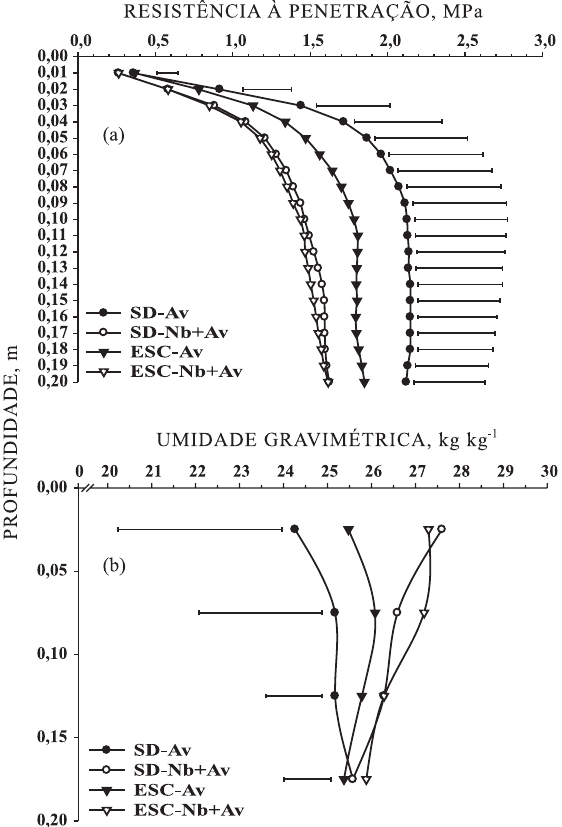
Figura 2. Resistência à penetração (a) e umidade gravimétrica (b) de um Latossolo Vermelho distroférrico sob diferentes sistemas de manejo. As barras horizontais indicam a